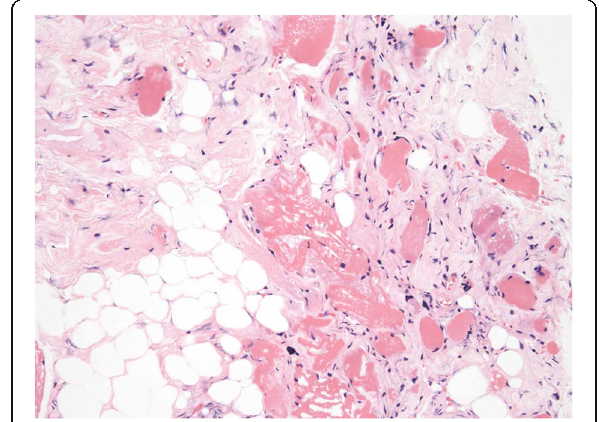
Fig. 4 Histopathological findings. Diffuse atrophy and fibrosis of the cricopharyngeus muscle fibers